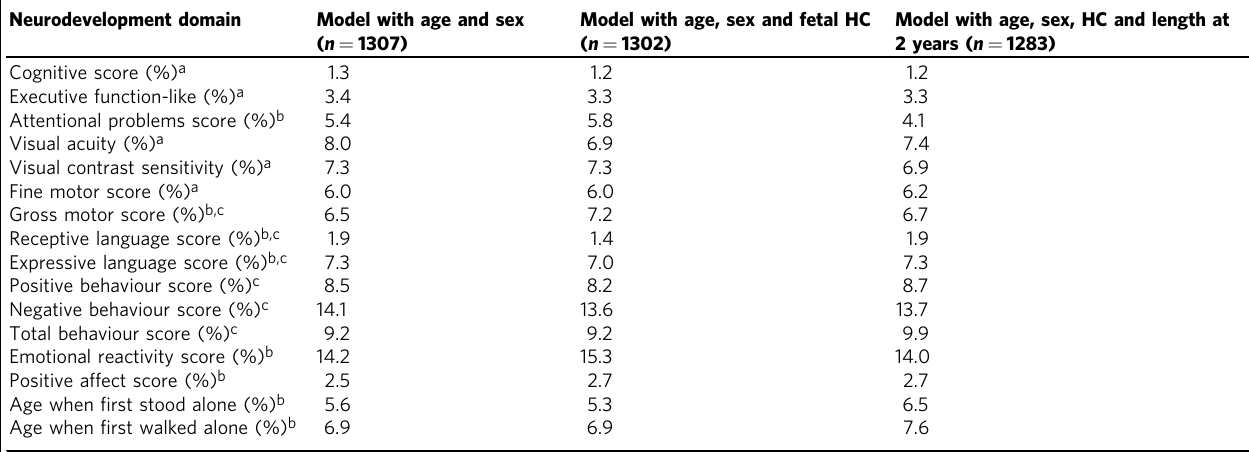
Table 3 Variance components analysis for individual domains of the INTERGROWTH-21 st Neurodevelopment Assessment Package showing variance between study sites as % of the total variance Neurodevelopment domain Model with age and sex Model with age, sex and fetal HC Model with age, sex, HC and length at ( n = 1307) ( n = 1302) 2 years ( n =